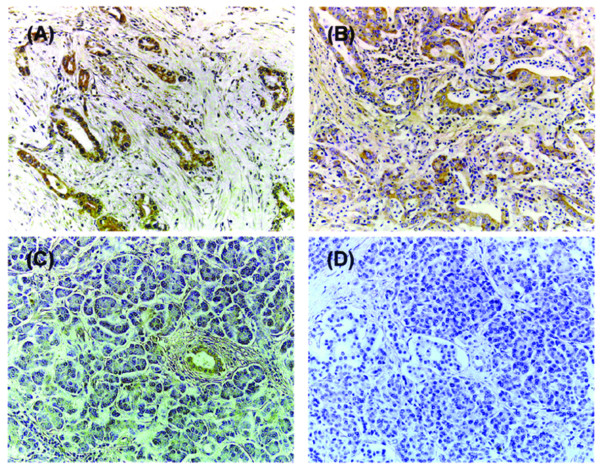
Expression of α6 integrin subunit and uPAR in specimens from pancreatic cancer patients. Tissue samples fixed in 10% formalin and embedded in paraffin were stained using the labeled streptavidin biotin method and specific antibodies as described in Materials and Methods. (A) Strong expression of the α6 integrin subunit in a specimen from ductal adenocarcinoma of pancreas. Magnification: ×200. (B) Strong expression of the uPAR in a specimen from ductal adenocarcinoma of pancreas. Magnification: ×200. (C) Weak expression of the α6 integrin subunit in a specimen from non-cancerous region of pancreas. Magnification: ×200. (D) The expression of uPAR was absent in a specimen from non-cancerous region of pancreas. Magnification: ×200.